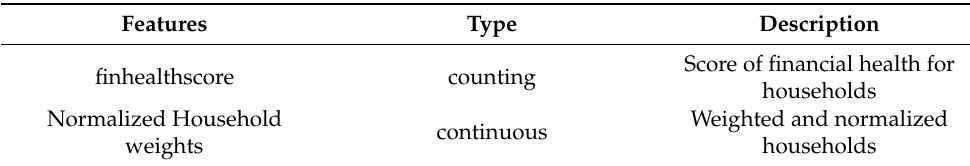
Table 8. Details of the variables.